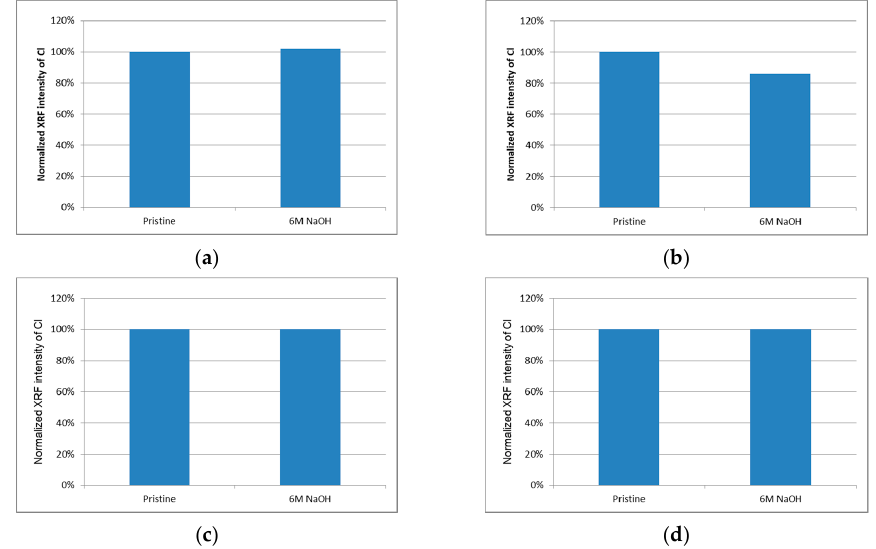
Figure 11. Normalized chlorine intensities obtained using XRF measurements before and after immersion in solutions of different alkali concentrations. ( a ) CMX, ( b ) AMX, ( c ) CMX precursor, and immersion in solutions of di ff erent alkali concentrations. ( a ) CMX, ( b ) AMX, ( c ) CMX precursor, and ( d ) ( d ) AMX precursor. AMX